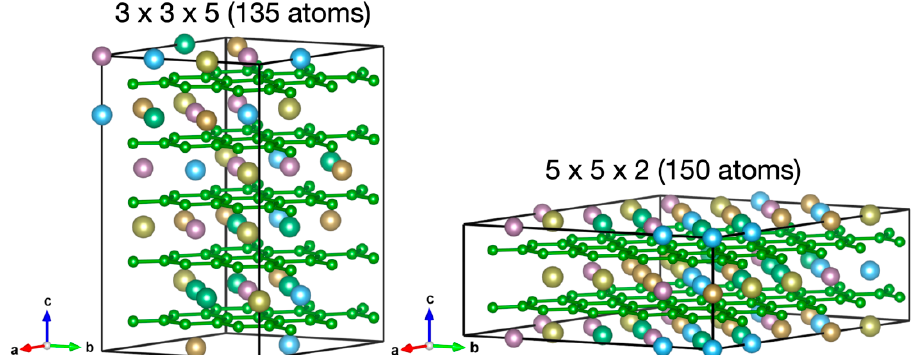
Figure 1. Special quasi-random structures (SQSs) for simulating the compression and mechanical behaviors of the hexagonal high-entropy boride (Hf, Mo, Nb, Ta, Ti)B 2 . The SQS structures include 135 atoms ( left ) and 150 atoms ( right ), which, respectively, can be regarded as 3 × 3 × 5 and 5 × 5 × 2 supercells of the parent lattice of the hexagonal AlB 2 structure. Figure 2a indicates that the volumes versus external pressure for different fully relaxed SQS structures agree extremely well. At ambient pressure, the volume of (Hf, Mo, Nb, Ta, Ti)B 2 from the 150-atom SQS structure (blue curve) is 27.47 Å 3 . This theoretically predicted volume is within 2% of the experimentally measured value of 26.882 Å 3 . Figure 2b shows the corresponding bulk and shear moduli as a function of pressure. In the 150-atom SQS results (blue curves), the ambient-pressure bulk and shear modulus values are, respectively, K 0 = 288 GPa and G 0 = 215 GPa. The theoretical value of K 0 is in good agreement with the experimentally determined K 0 = 276